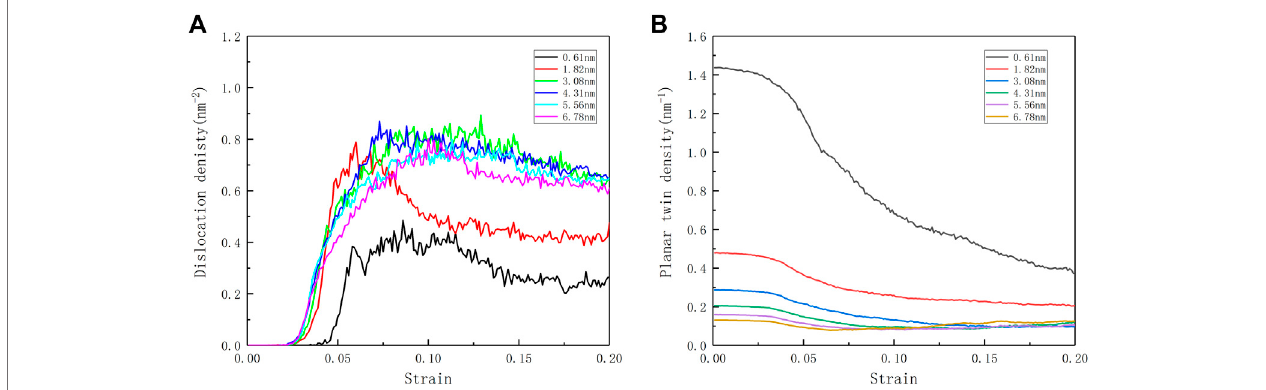
FIGURE 4| (A) Evolution curves ofdislocation density ρ during deformation of the nt-HEAs with different twin boundary spacing. (B) Evolution curvesof the planar twin (TB) densities as a function of strain.